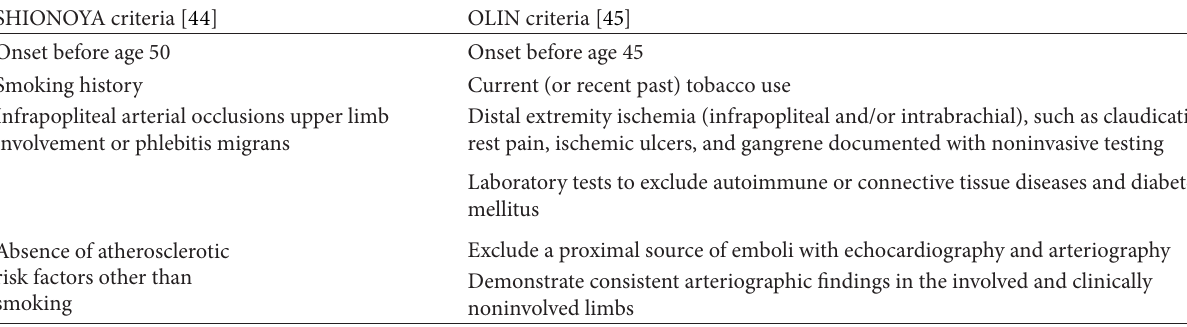
Table 4: Diagnostic